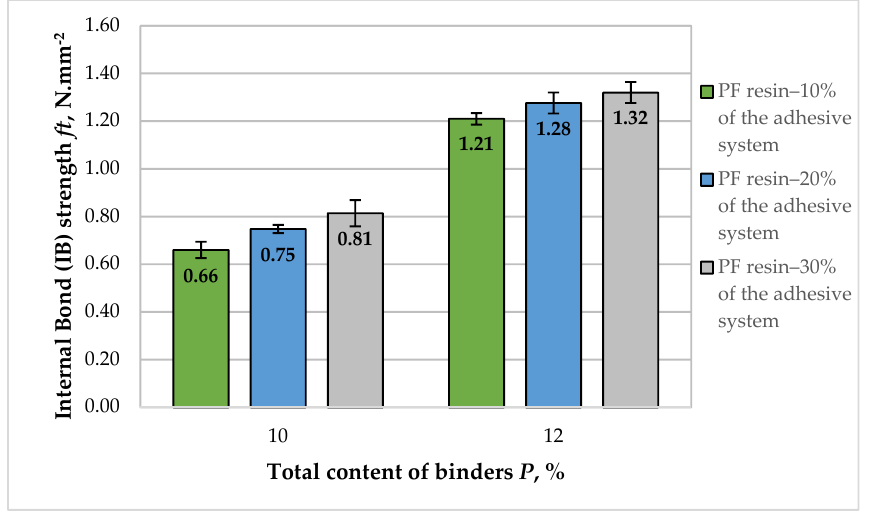
Figure 7. Internal bond (IB) of fiberboard panels bonded with HL and PF resin.